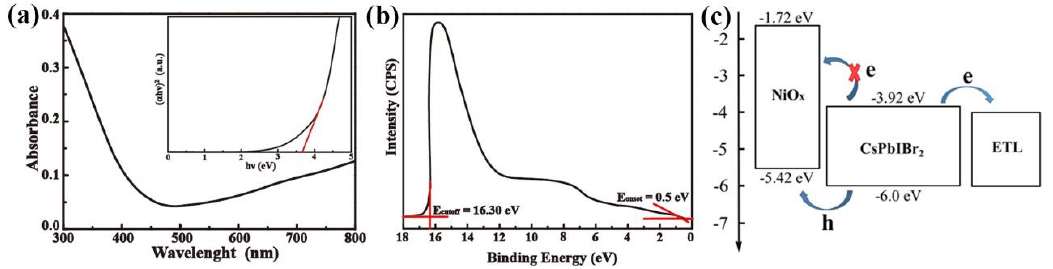
Figure 1. ( a ) U ltraviolet–visible (UV-Vis) absorption spectra of NiO x film deposited on glass substrate. (The inset is the plots of the (αhν) 2 versus energy). ( b ) Ultraviolet photoelectron spectroscopy (UPS) spectra of the NiO x film deposited on the ITO substrate. ( c ) The band alignment between a NiO x film and perovskite film.